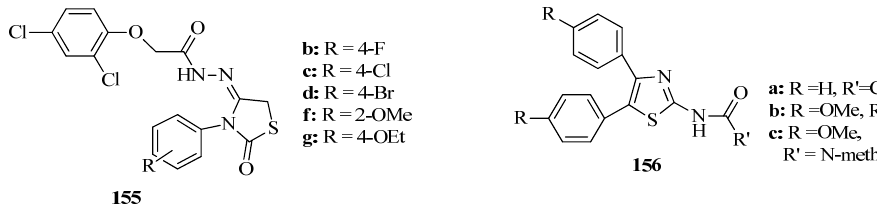
Figure 60. Structures of 2-imino-4-thiazolidinone derivatives and